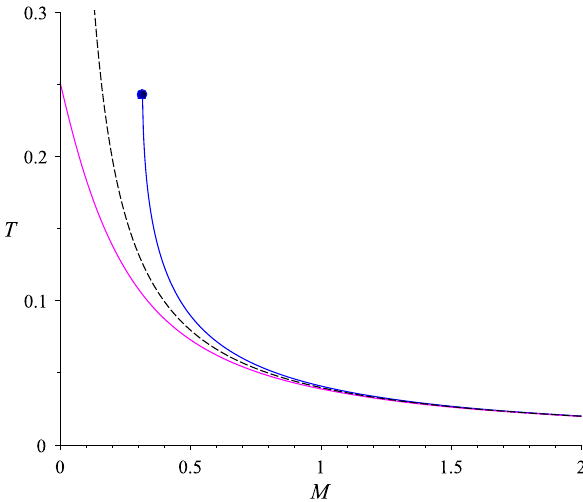
Fig. 1 The Hawking temperature of an asymptotically flat Schwarzschild black hole. The middle dashed curve corresponds to the usual picture of Hawking evaporation, which diverges as M → 0. The divergence is removed with GUP correction. Specifically, if α > 0, the temperature curve terminates at around M ∼ shown by the right-most curve. If α < 0, however, GUP correction no longer imposes a lower bound on the black hole size. This corresponds to the left-most curve: the temperature remains finite as the black hole appears to shrink down to zero size